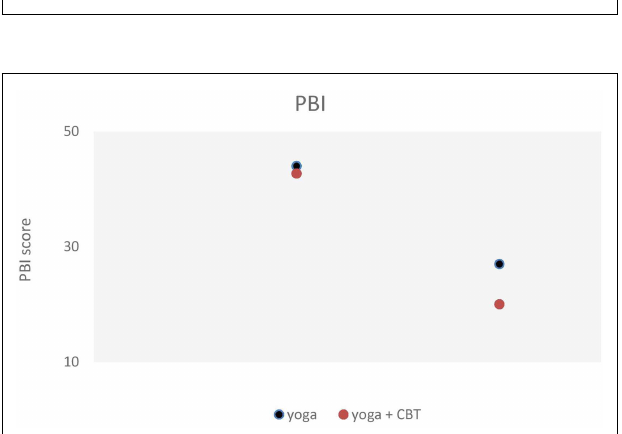
FIGURE 2 | Percentage values for all levels of anxiety (BAI) for both groups across experimental time .